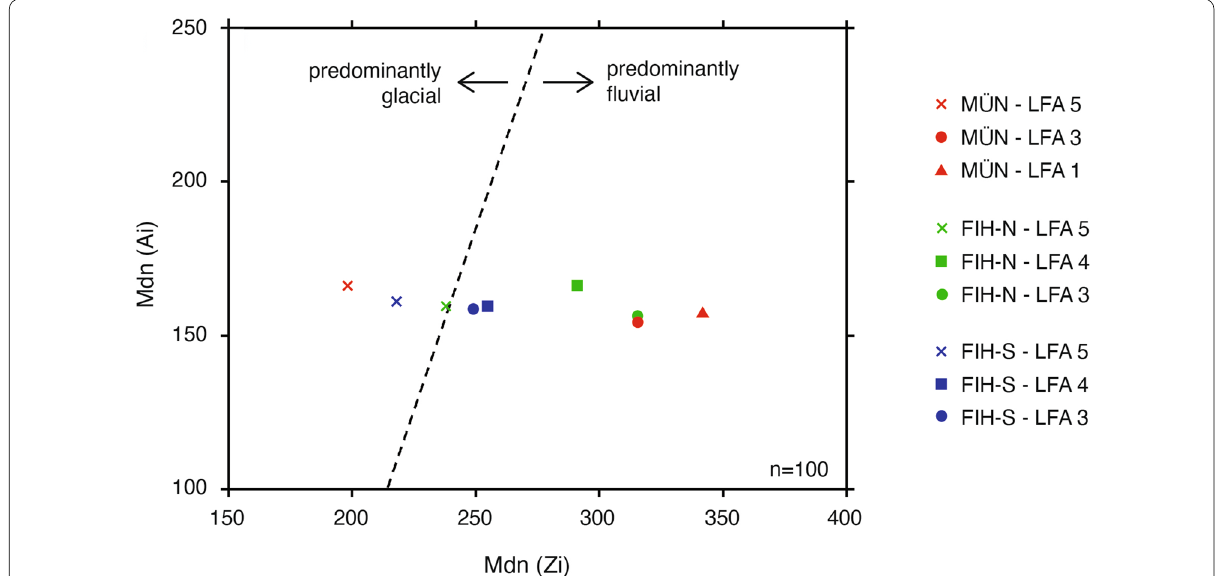
Fig. 9 Ai–Zi plot showing the median values of the flattening ( Ai ) and roundness indexes ( Zi ) of quartzite clasts collected at MÜN, FIH-S, and FIH-N. Low Zi values angular pebbles, high Zi values = pebbles. After Schlüchter